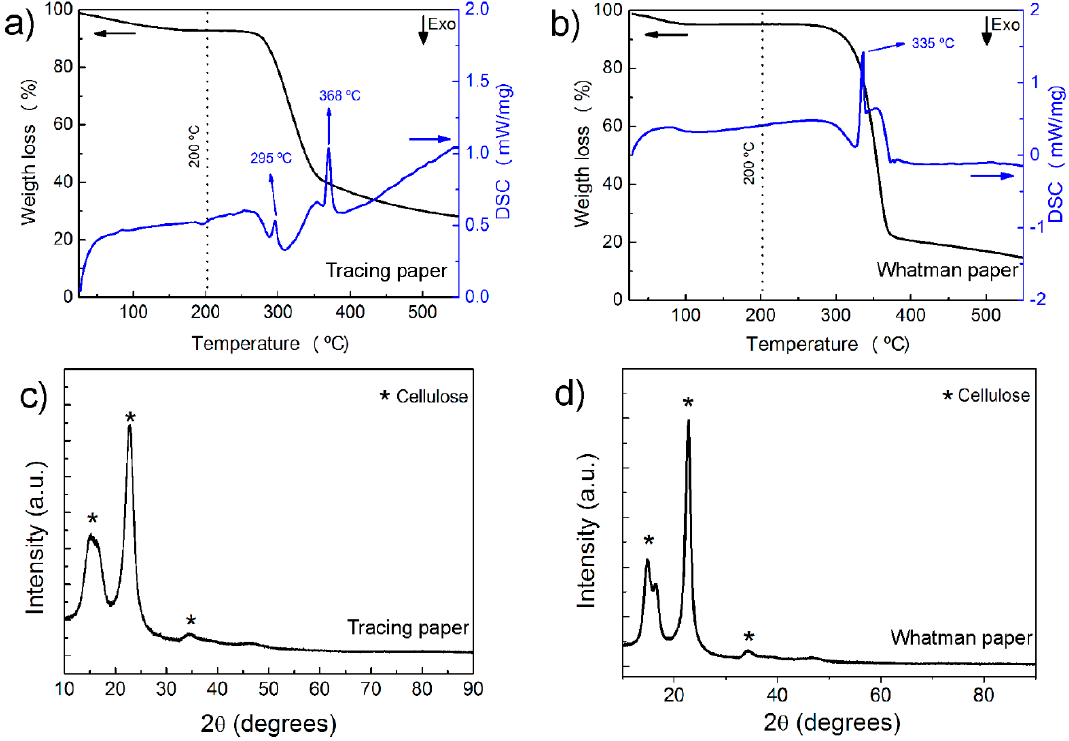
Figure 2. ( a , b ) Differential Scanning Calorimetry (DSC) and ( c , d ) X-ray diffraction (XRD) diffractograms of tracing and Whatman paper substrates, respectively. of tracing and Whatman paper substrates,